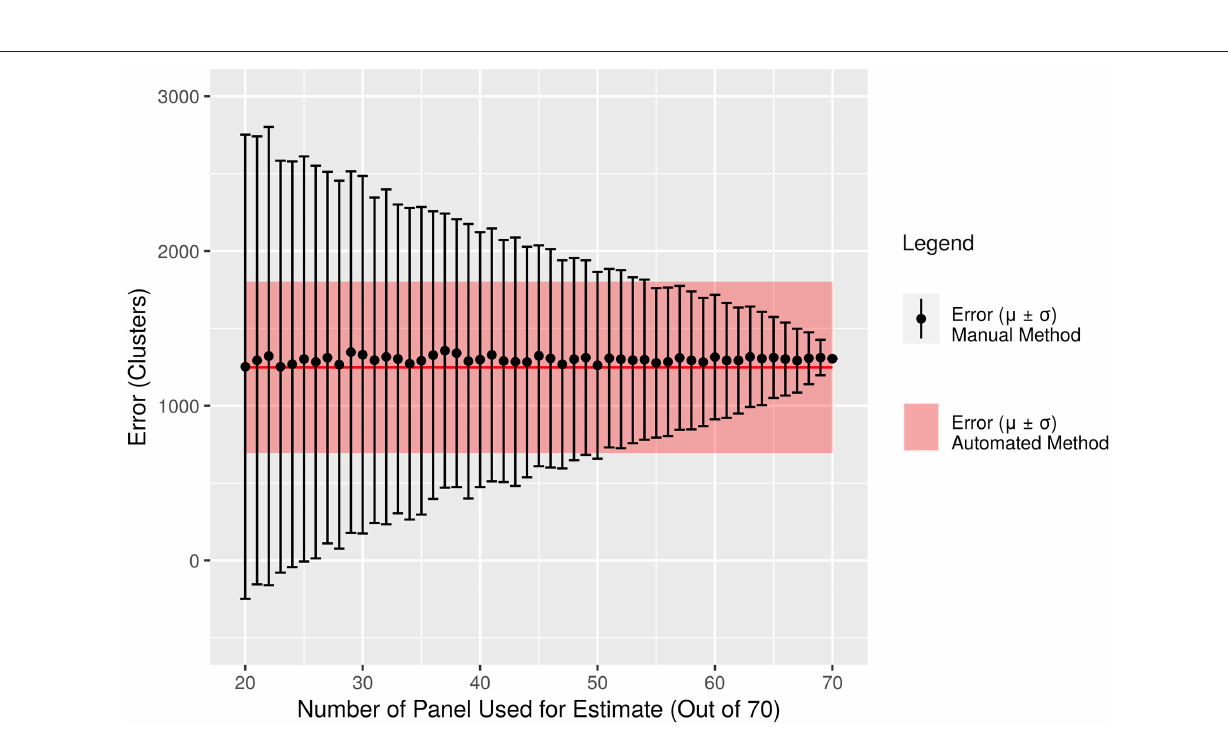
Frontiers in Agronomy |